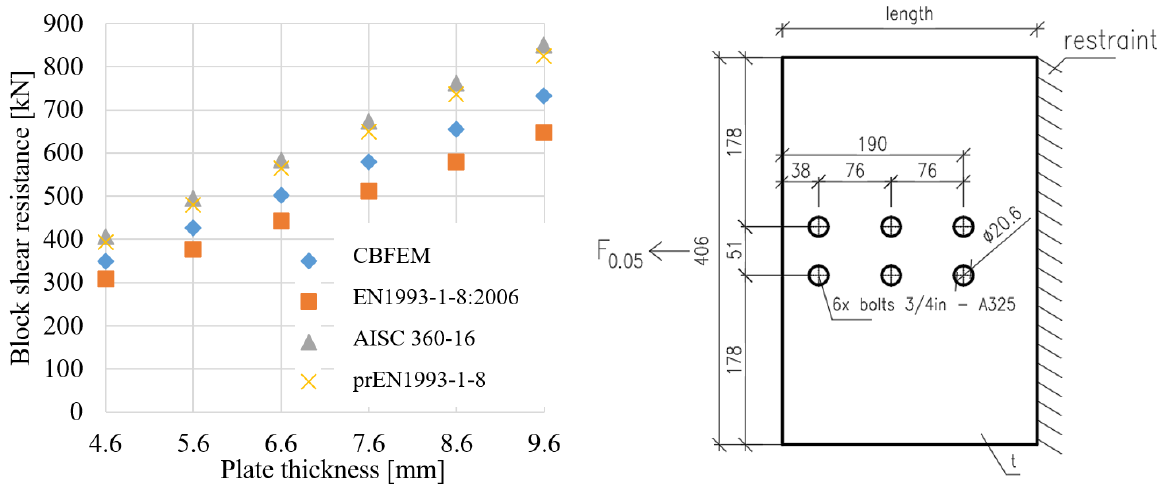
Figure 17. Sensitivity study of block shear resistance for plate thickness, dimensions in mm.